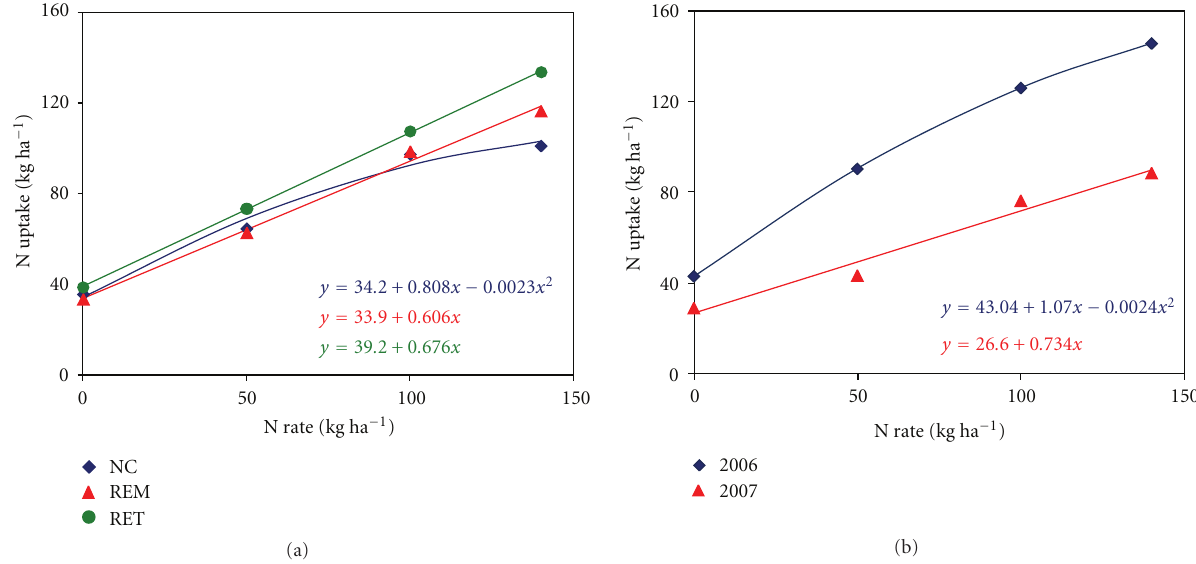
Figure 8: Cotton N uptake between first square and cutout as a ff ected by (a) rye residue management and N rate (averaged across years) and (b) year and N rate (averaged across rye residue